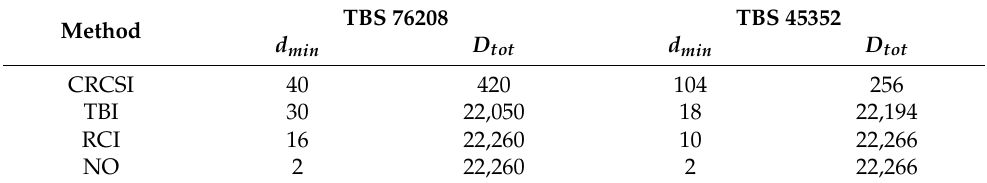
Table 2. Comparison of minimum distance and multiplicity for fixed reception.